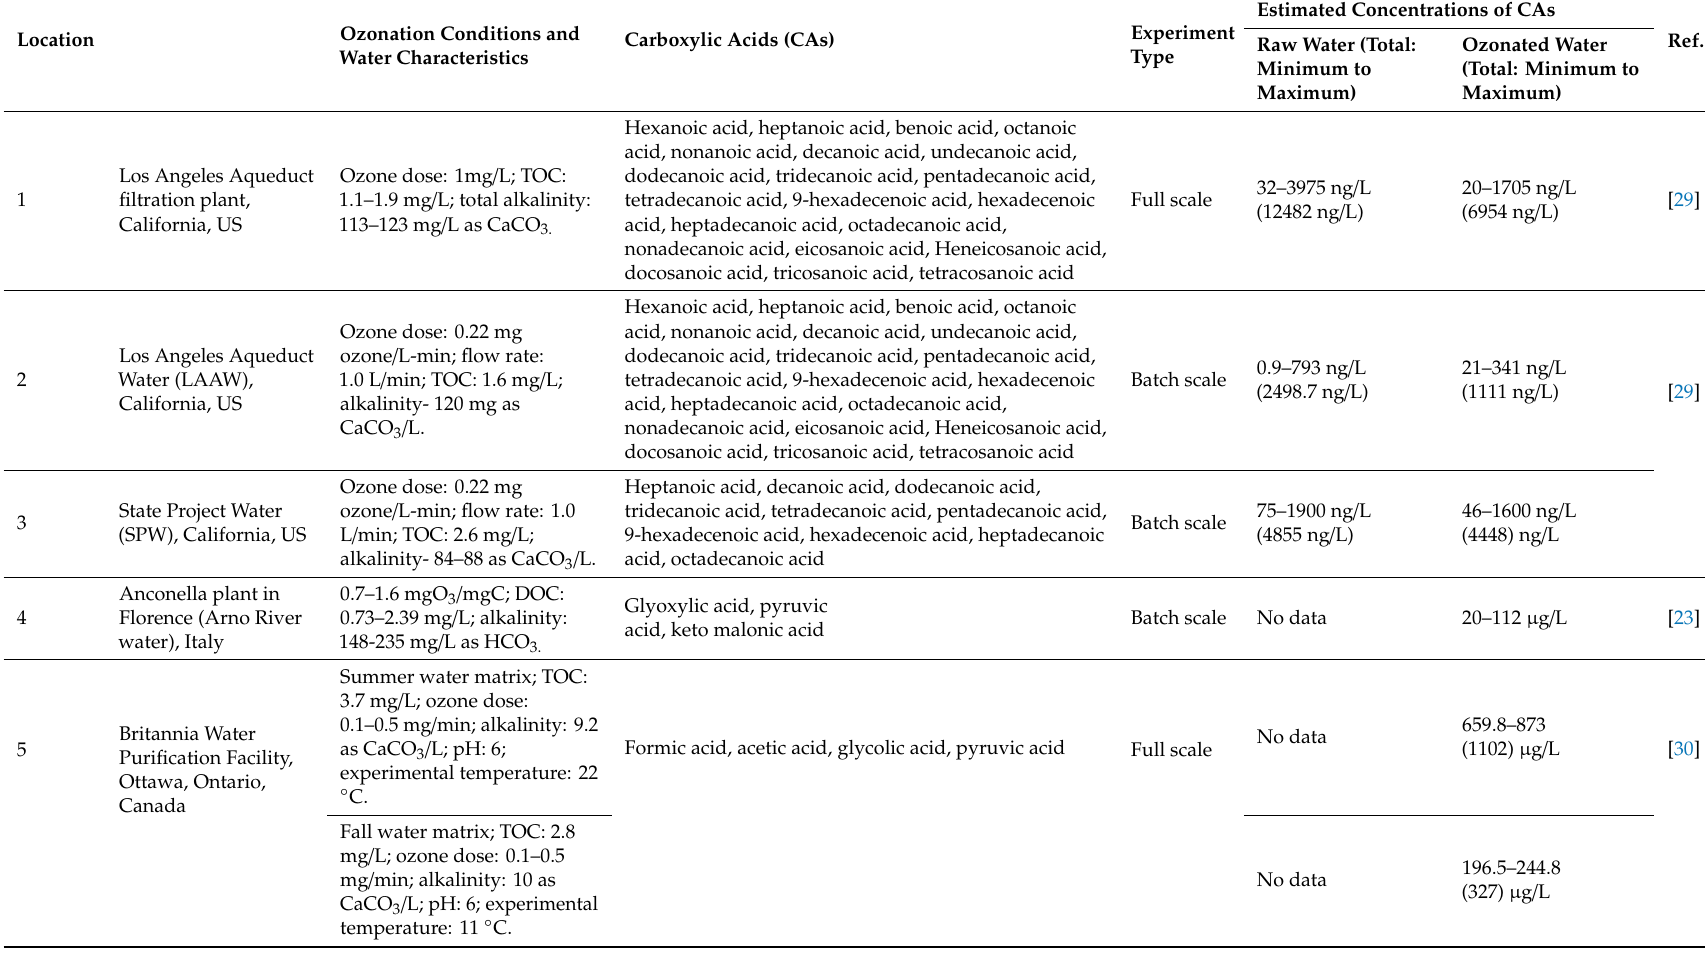
Table 1. Levels of carboxylic acid by-products (CABPs) reported in ozonated drinking water samples across the